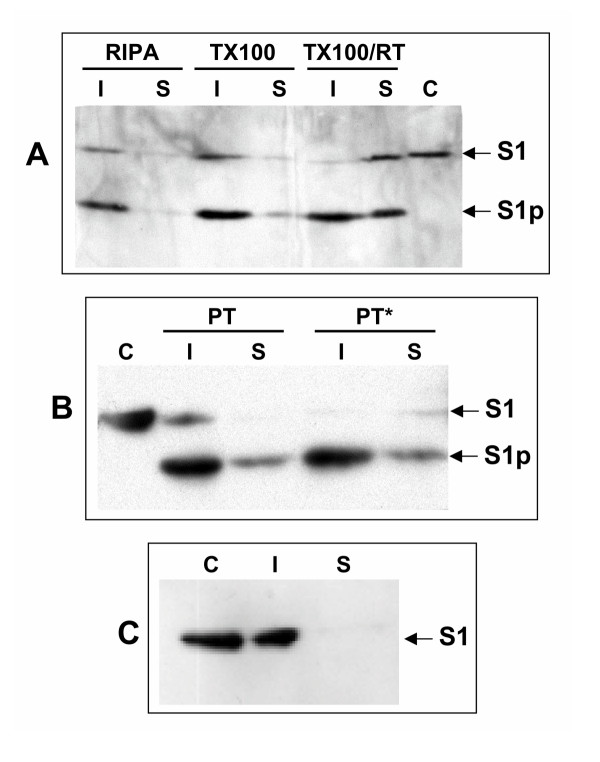
S1 processing and detergent fractionation in CHO cells. (A) Cells were incubated with PT (20 nM) for 4 h followed by lysis with RIPA or Triton X-100 (TX100) buffer on ice or at room temperature (RT). A western blot of the detergent-insoluble (I) and -soluble (S) fractions is shown, with bands corresponding to full length S1 or processed S1 (S1p) indicated. Lane marked C is PT (200 ng) loading control. (B) Western blot of Triton X-100 lysate fractions of CHO cells treated with PT or PT* (catalytically inactive mutant of PT) for 4 h. (C) Western blot of Triton X-100 lysate fractions of untreated CHO cells after addition of 500 ng PT to the lysis mixture.